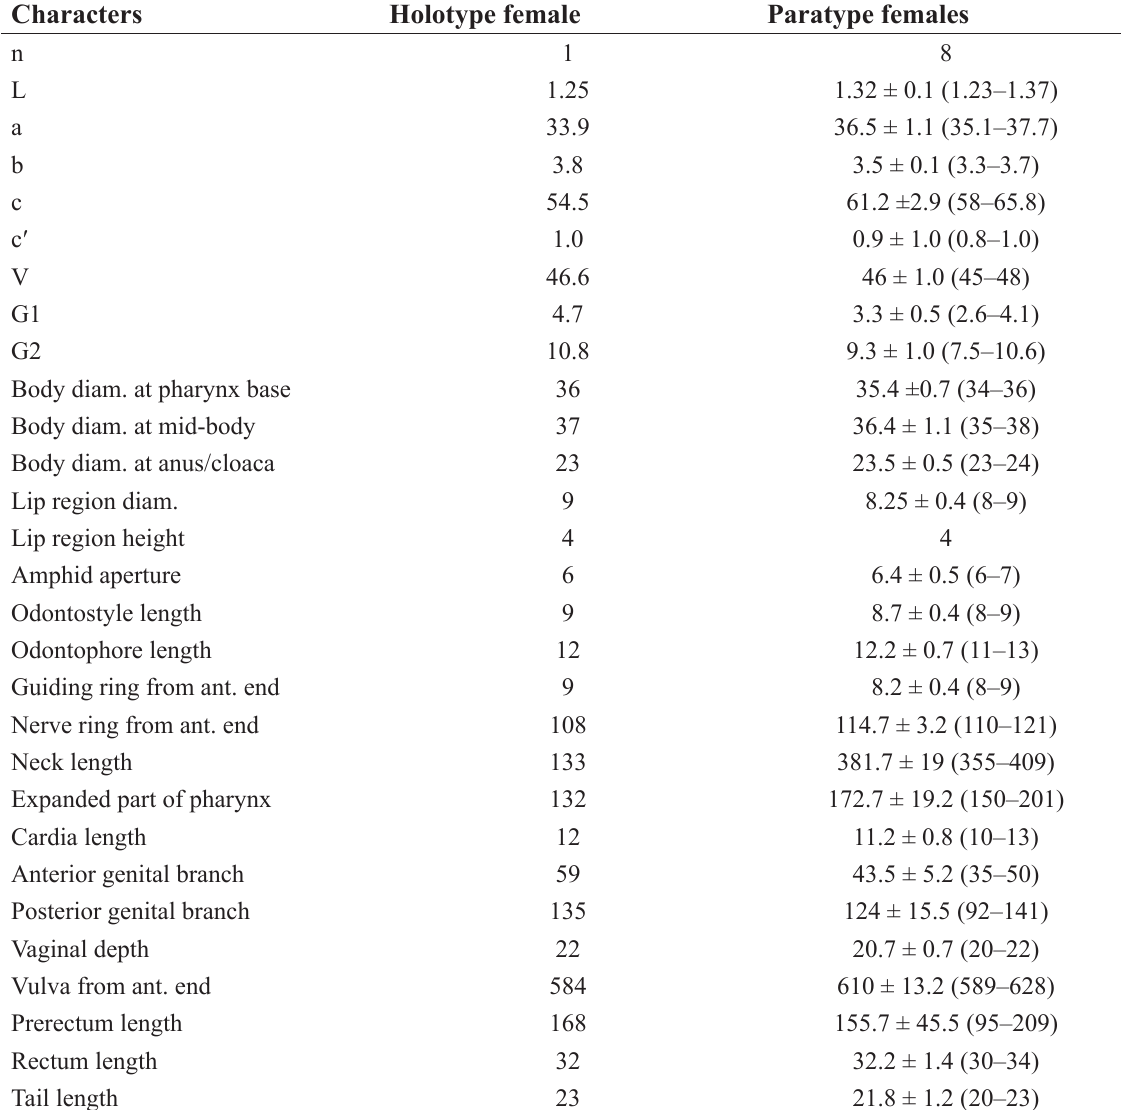
Table 5. Morphometrics of Axonchium indicum sp. nov. All measurements in µm except L in mm, and in the form: mean ± s.d.